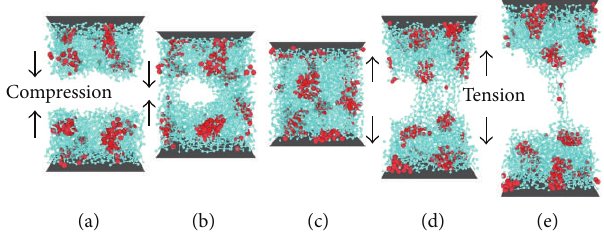
Figure 36: The simulated nanomechanics for functional PFPE ( 𝜀 𝑝 𝑏 = = 3𝜀 ) films: (a) two well-equilibrated films approach each other, 𝜀 𝑝 𝑤 so-called “compression”; (b) two films are in contact; (c) two films completely contact and merge into one confined film; (d) the top surface is retracted, so-called “tension”; and (e) the confined film is being separated into two parts in the nearly end of the “tension.” Note that light blue indicates the backbone beads and red represents the functional end